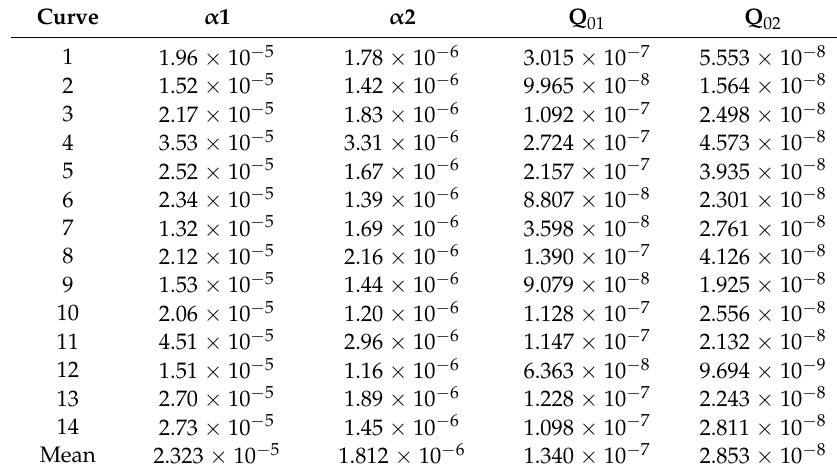
Table 2. Parameters of the models of two deposits.